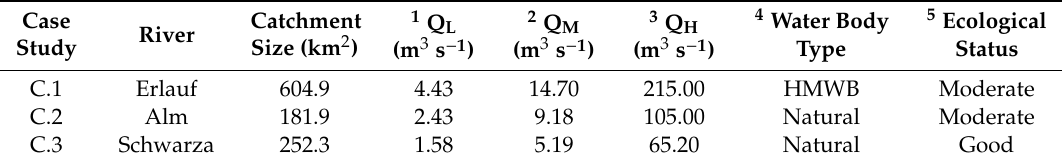
Figure 1. ( a ) European map and the Austrian territory (black). ( b ) Detailed overview of the three rivers (blue lines) and location of the case studies (black dots). Table 1. Relevant hydrological parameters and description of the ecological status according to the Water Framework Directive (2000/60/EC).